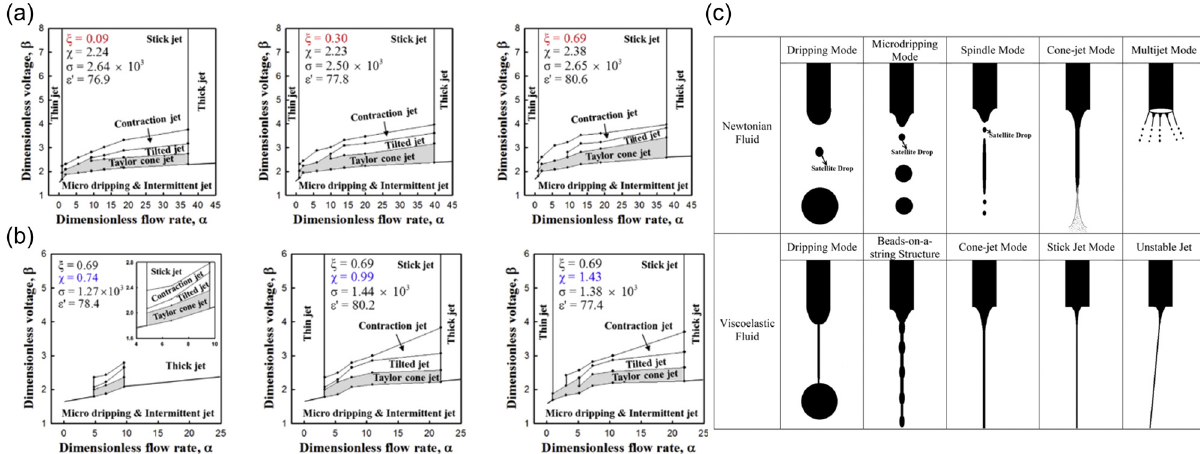
Figure 9: ( a ) From top to bottom, from left to right, the jet windows of six PEO solutions with di ff erent molecular weights: M03, M06, M10, M20, M40, and M50. For example, M10 represents a PEO solution with a molecular weight of 1.0 × 10 6 g/mol. ( b ) From top to bottom, from left to right, the jet window diagrams of six PEO solutions with di ff erent viscosities: C18, C24, C30, C38, C42, C52. For example, C18 means 0.18 wt% PEO solution. Reproduced from ref. [ 122 ] with permission from Elsevier BV. ( c ) Comparison of the jet modes of Newtonian fl uid and viscoelastic fl uid. Reproduced from ref. [ 123 ] with permission from American Institute of